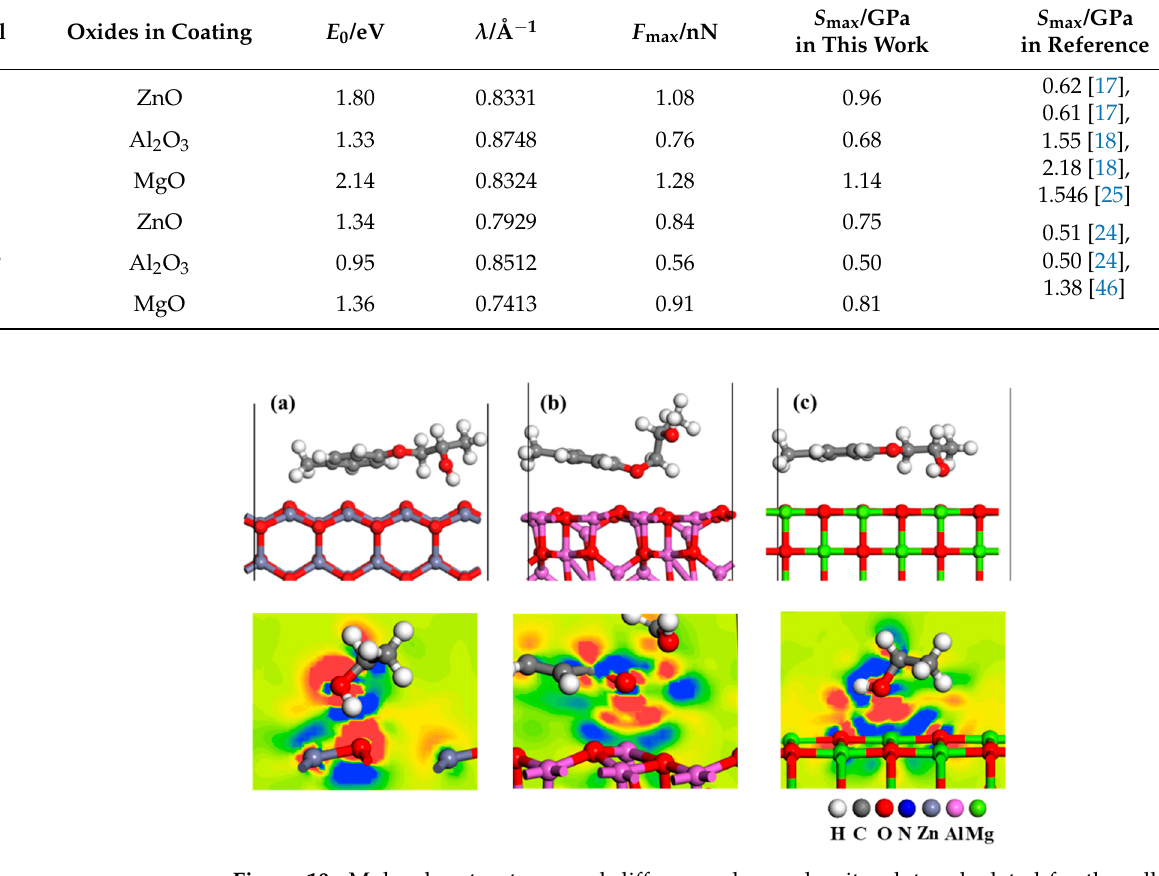
Figure 10. Molecular structures and di ff erence charge density plots calculated for the adhesive in- terface of ( a ) ZnO, ( b ) Al 2 O 3 , and ( c ) MgO models (electron failure depletion = blue; electron accu- mulation =